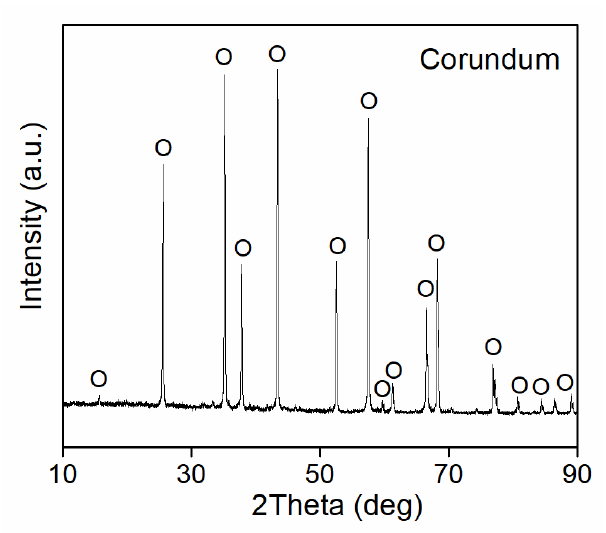
Figure A6. XRD result for burned umber. Hematite (H) was identified.